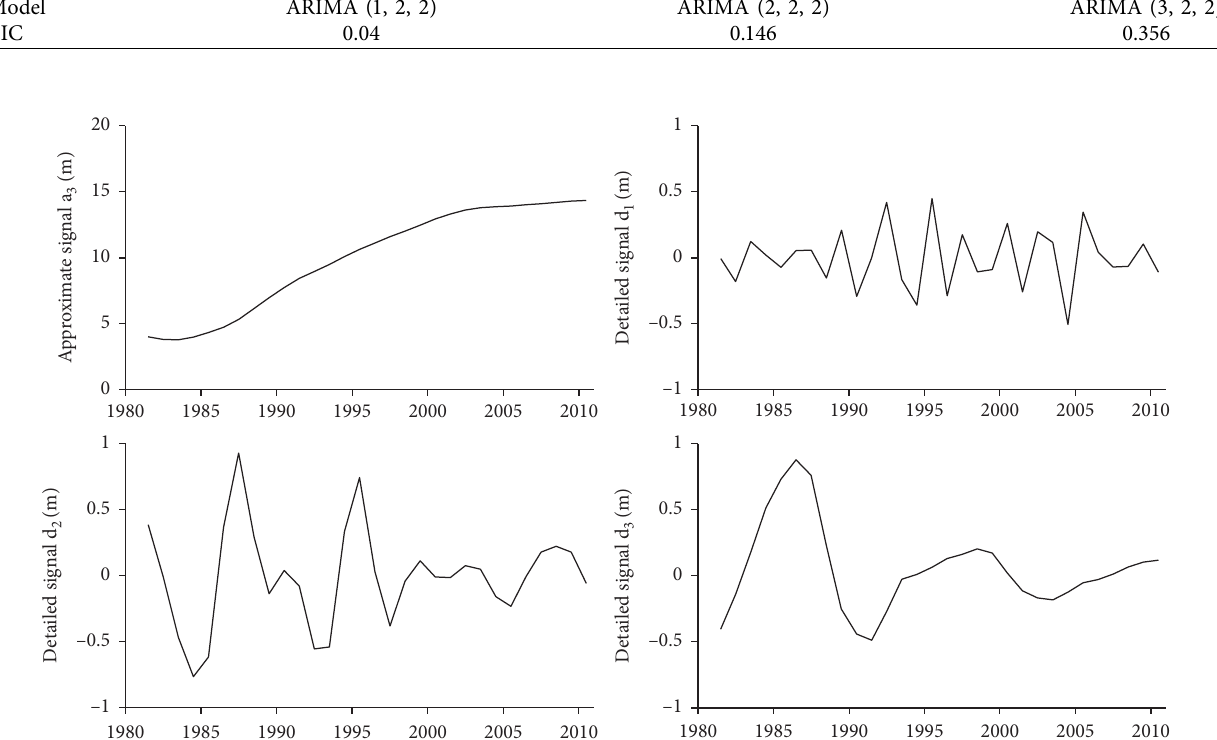
Figure 5: The average groundwater depth series, three detailed signal sequences, and approximate signal sequence through wavelet decomposition and